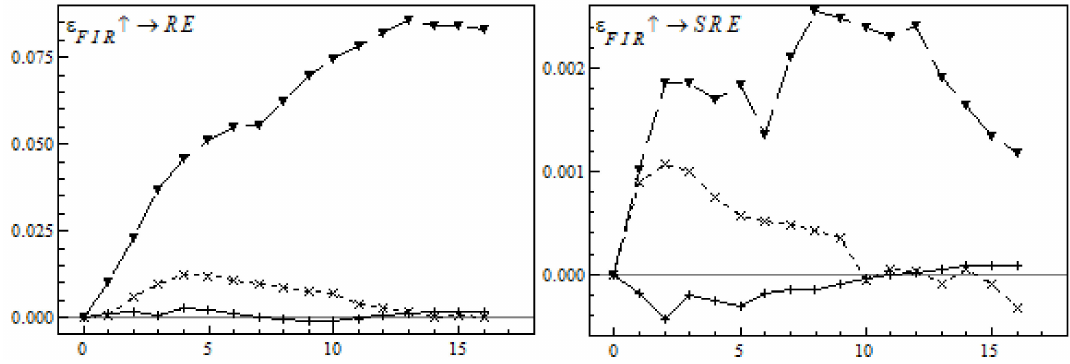
Figure 4. Time-varying impulse response diagram at different